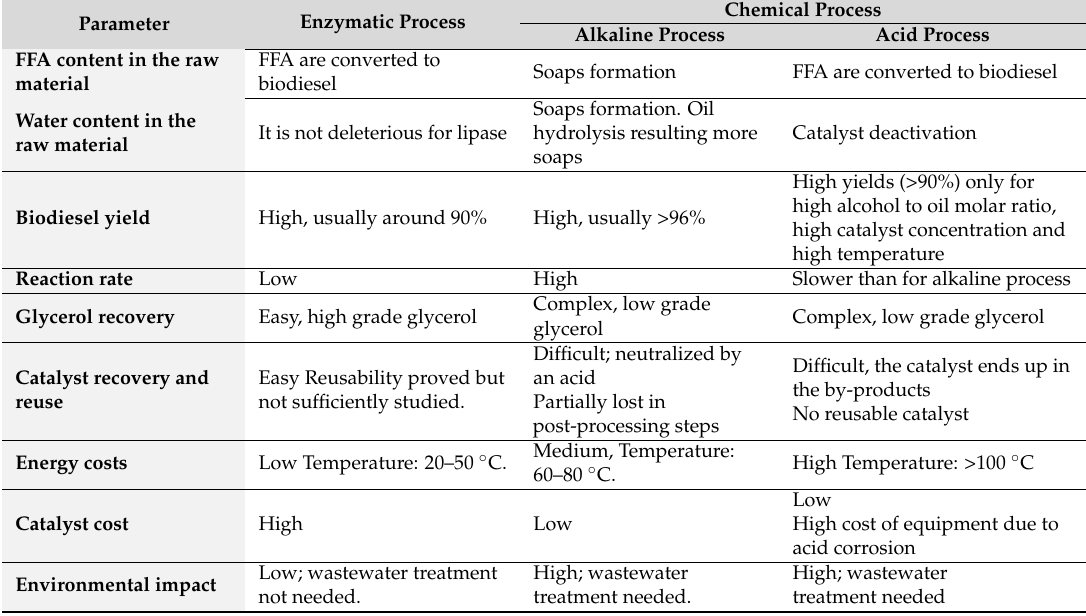
Table 1. Comparison of enzymatic technology versus chemical (alkaline and acid) technology for biodiesel